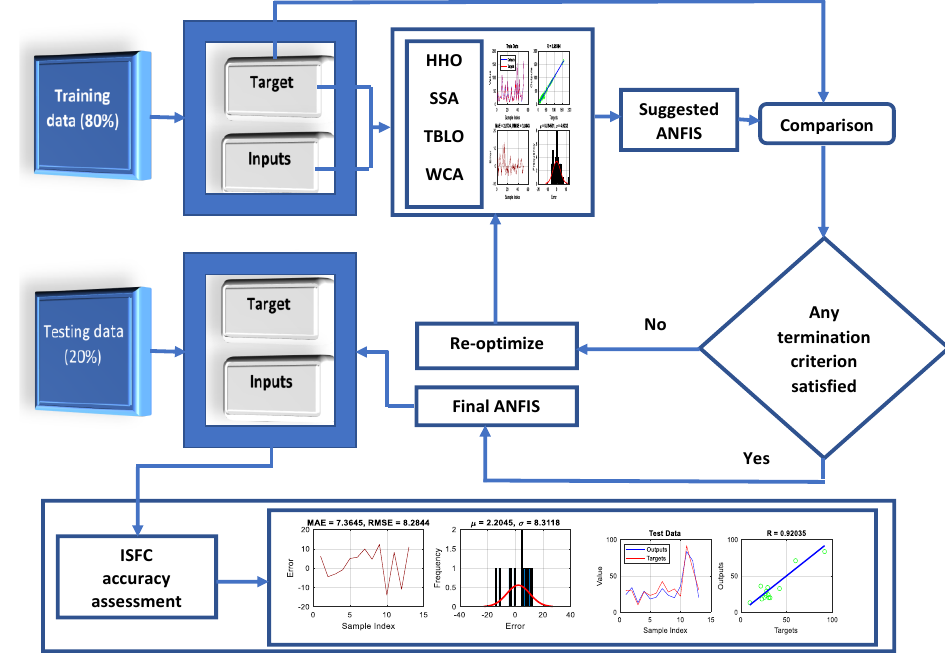
Figure 2. The optimization scheme using the HHO, SSA, TLBO, and WCA.